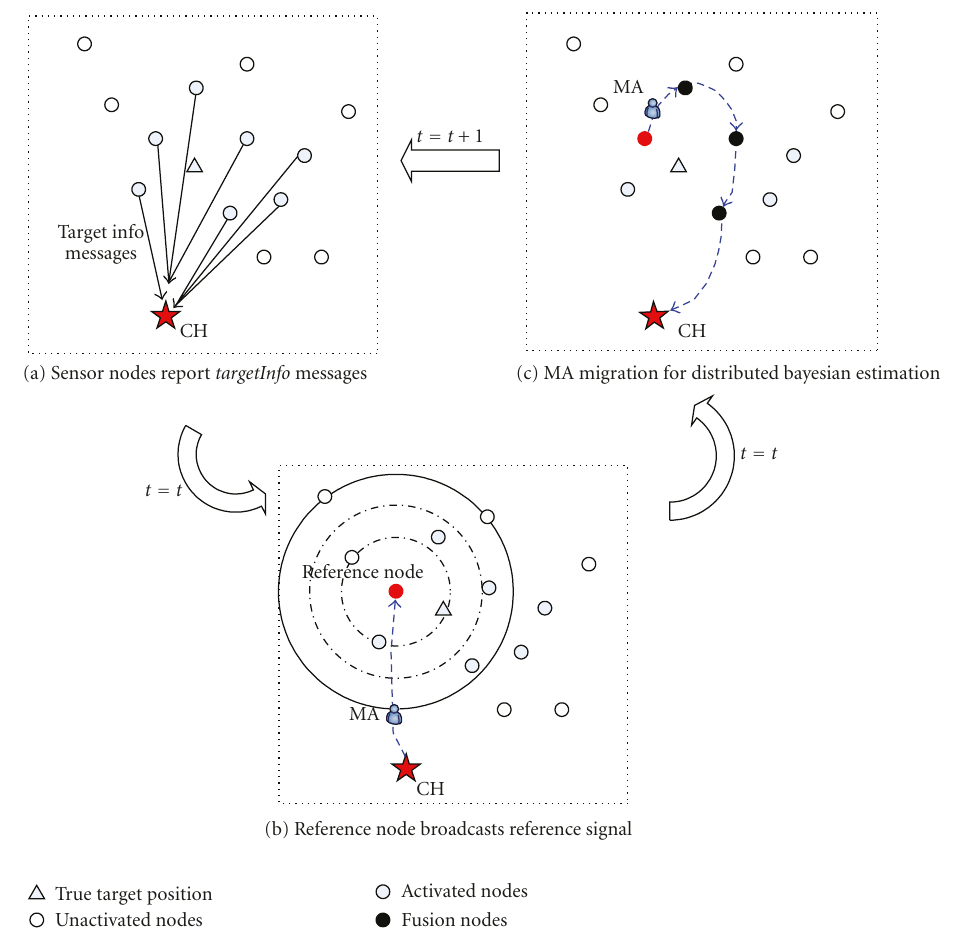
Figure 1: The illustration of proposed distributed processing framework for acoustic target